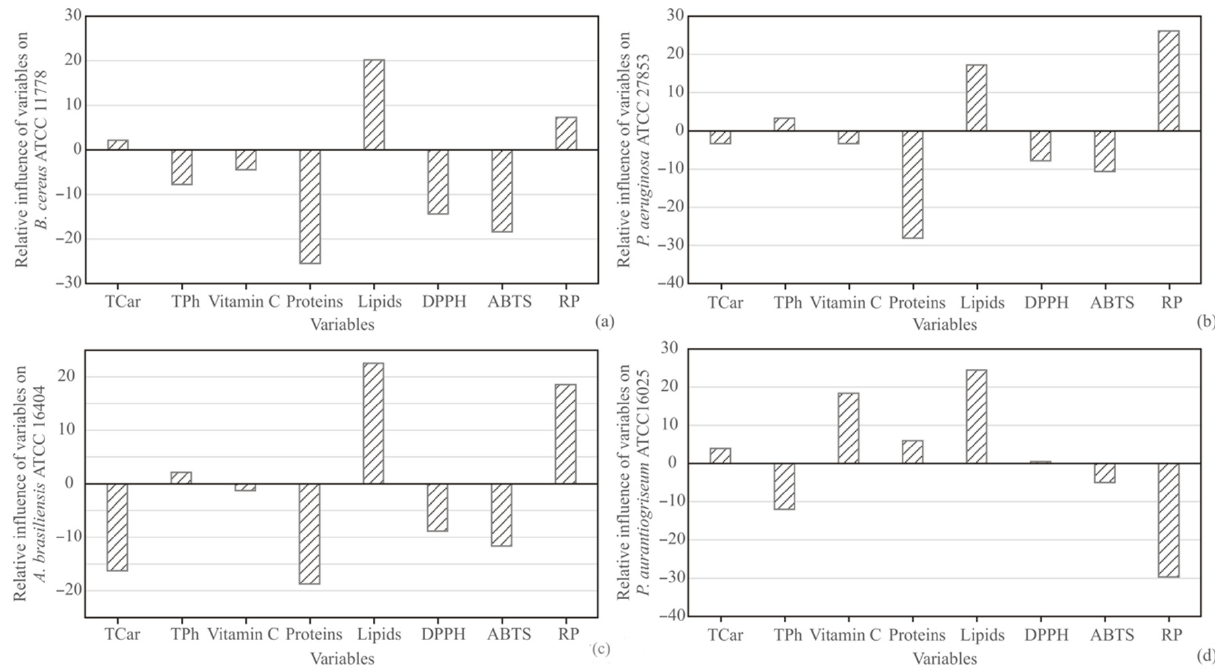
Figure 5. The relative importance of input variables (TCar, TPh, Vitamin C, Proteins, Lipids, DPPH, ABTS and RP) on ( a ) B. cereus ATCC 11778, ( b ) P. aeruginosa ATCC 27853, ( c ) A. brasiliensis ATCC 16404 and ( d ) P. aurantiogriseum ATCC 16025 in peel.